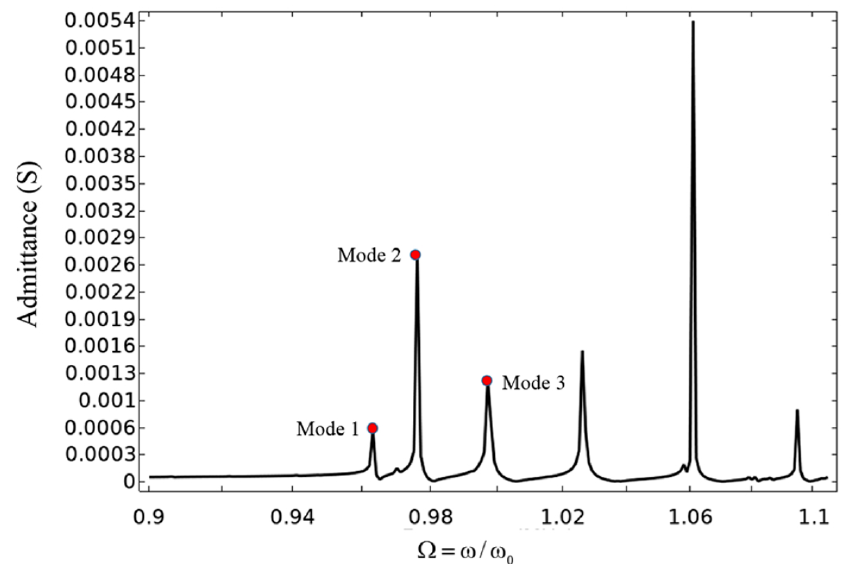
Figure 7. The admittance curve of the lateral field excitation (LFE) resonator from COMSOL.